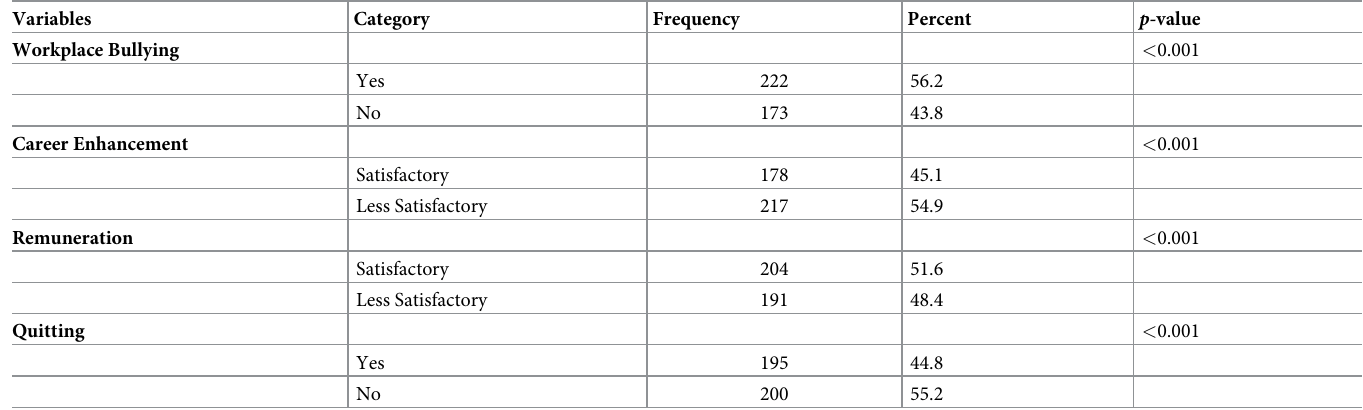
Table 3. Workplace contextual factors associated with compassion fatigue among nurses.